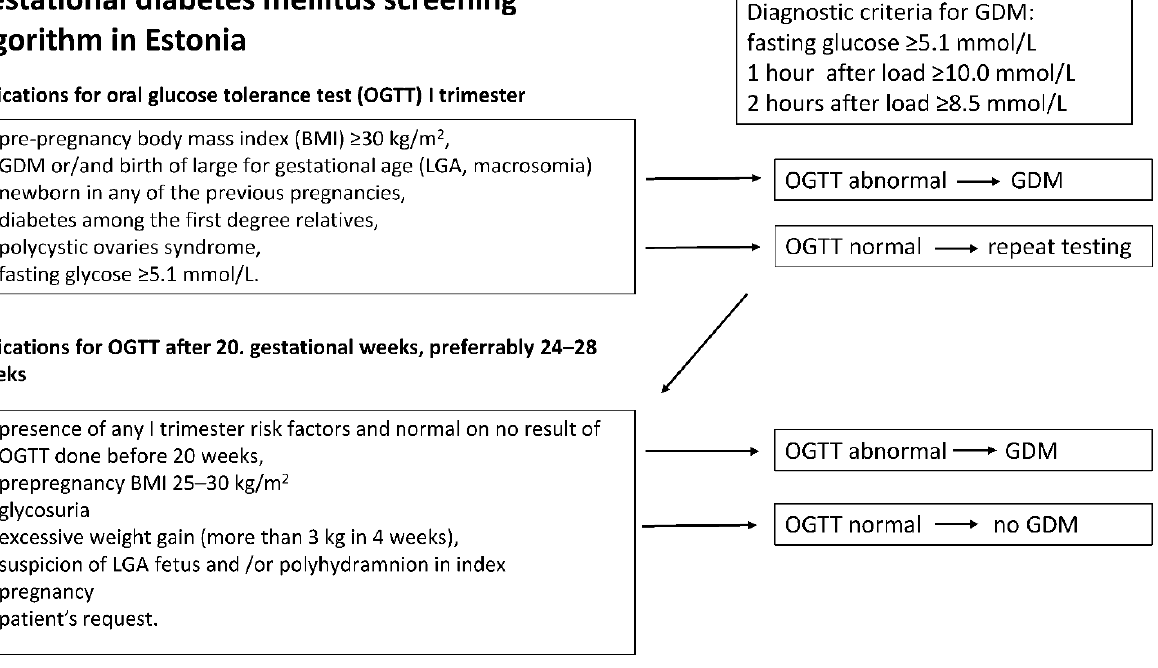
Figure 1. Gestational diabetes mellitus screening algorithm in Estonia.